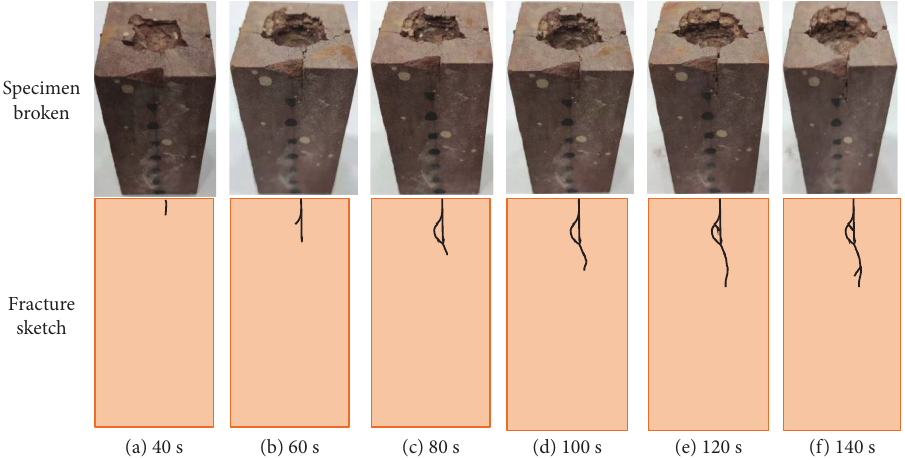
Figure 8: Illustration of fracture propagation. (a) 40s. (b) 60s. (c) 80s. (d) 100s. (e) 120s. (f)